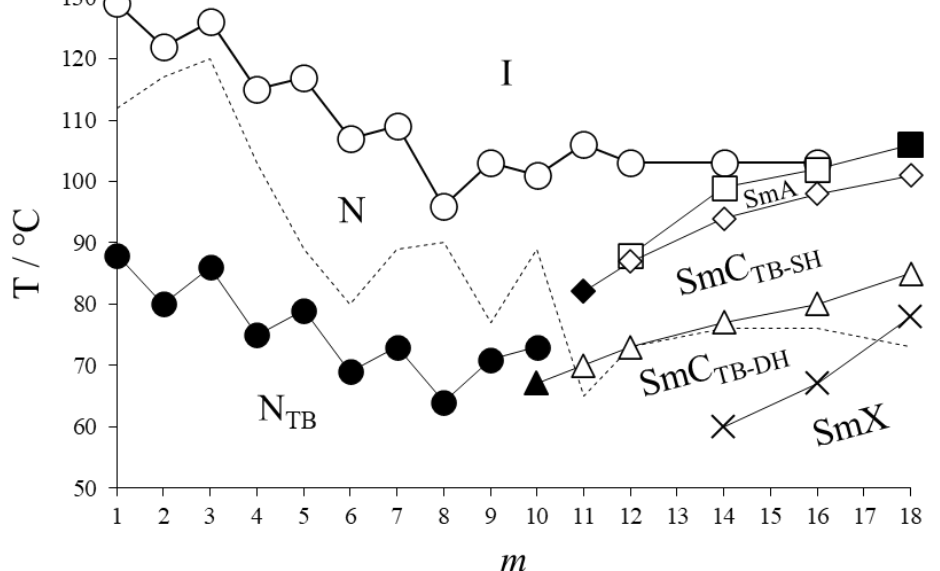
Figure 13. The dependence of the transition temperatures on the number of carbon atoms, m , in the terminal chain for the CB6O. m series [40,91]. The melting points are connected by the broken lines. Unfilled circles denote T NI ; filled circles T NTBN ; filled squares T SmAI ; unfilled squares T SmAN ; unfilled diamonds T SmCTB-SHSmA ; filled diamonds T SmCTB-SHN ; unfilled triangles T SmCTB-DHSmCTB-SH ; filled triangles T SmCTB-DHNTB ; crosses T SmXSmCTB-DH .